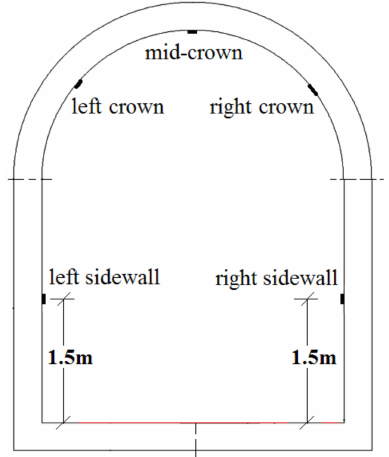
Figure 15. Schematic layout of SASW test stations at each test section.